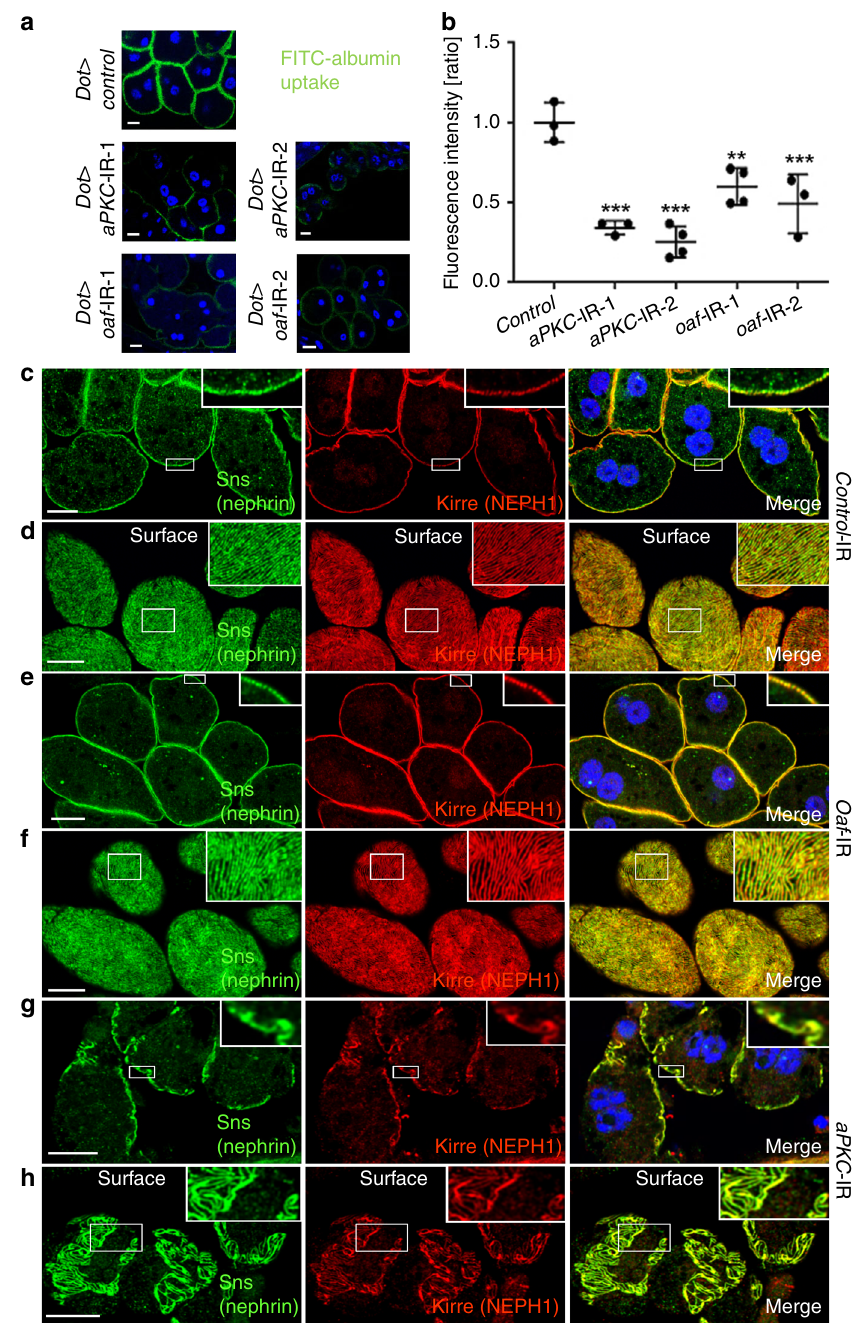
Fig. 8 In vivo results of Drosophila orthologs. The Drosophila orthologs of OAF and PRKCI ( aPKC ) are both required for nephrocyte function and aPKC -RNAi affects slit diaphragm formation. a Garland cell nephrocytes were exposed to FITC-albumin. Nephrocytes expressing control RNAi exhibit intense endocytosis, while expression of RNAi directed against oaf and aPKC (ortholog of PRKCI ) decreases tracer uptake. b Quantitation of fl uorescence intensity from FITC-albumin uptake is shown for the indicated genotypes. Values are presented as mean ± standard deviation of the ratio to a control experiment. Statistical signi fi cance was calculated using ANOVA and Dunnett ’ s post hoc analysis. A statistically signi fi cant difference (de fi ned as p < 0.05) is observed for oaf- RNAi-1 ( N = 4), oaf -RNAi-2 ( N = 3), aPKC -RNAi-1 ( N = 3), and aPKC -RNAi-2 ( N = 4), where ** indicate p < 0.01 and *** p < 0.001. c Staining the slit diaphragm proteins Sns (ortholog of nephrin) and Kirre (ortholog of NEPH1) in control nephrocytes shows regular formation of slit diaphragms. Airyscan technology partially allows for distinguishing individual slit diaphragms (insets). d Tangential sections through the surface of control nephrocytes reveals the regular fi ngerprint-like pattern of slit diaphragm proteins. e , f Expression of oaf -RNAi-1 does not entail an overt phenotype, suggesting reduced nephrocyte function may be a consequence of impaired protein reabsorption while slit diaphragm formation is not affected. g , h Expression of aPKC -RNAi-1 results in a clustered and irregular pattern of slit diaphragm proteins (insets in g ) and a complete loss of slit diaphragm protein distinct areas on the cell surface. This suggests the loss of nephrocyte function is a consequence of impaired slit diaphragm formation. All scale bars represent 10 µ